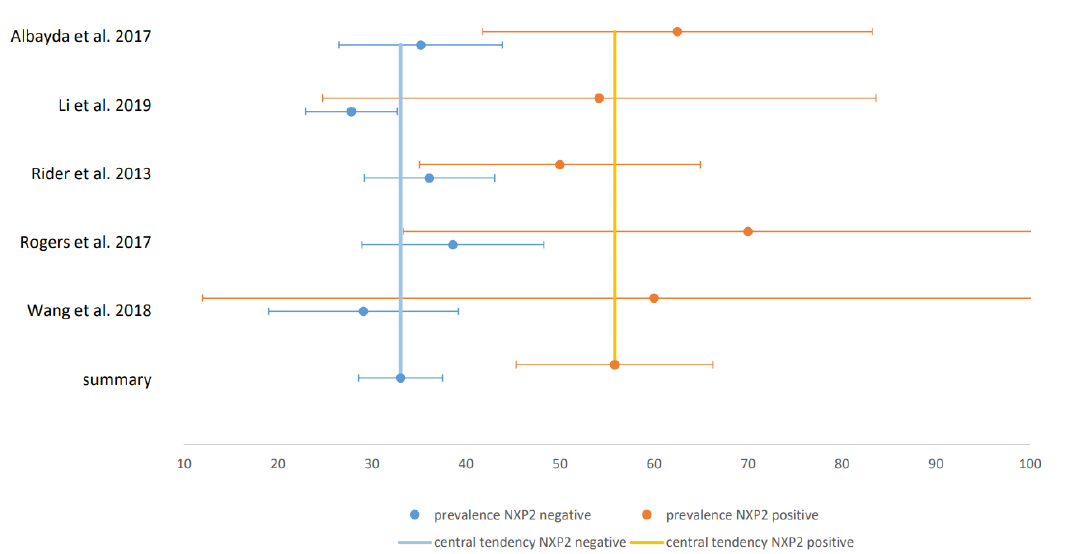
Figure 5. Forest plot for NXP2: Forest plot of the studies comparing prevalence in NXP2-positive and -negative IIM: x-axis shows the prevalence in %.